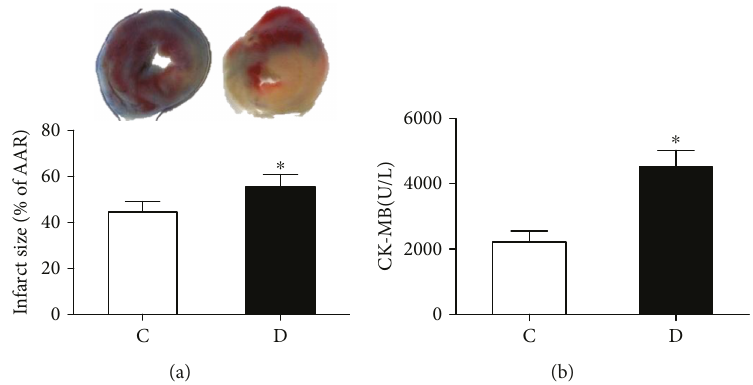
Figure 1: Control (C) or streptozotocin-induced diabetic (D) rats were subjected to 30min of myocardial ischemia followed by 2h of reperfusion. (a) Myocardial infarct size. (b) Plasma CK-MB levels. All values are expressed as means ± S.D., n = 8 . ∗ P < 0 05 versus C group.